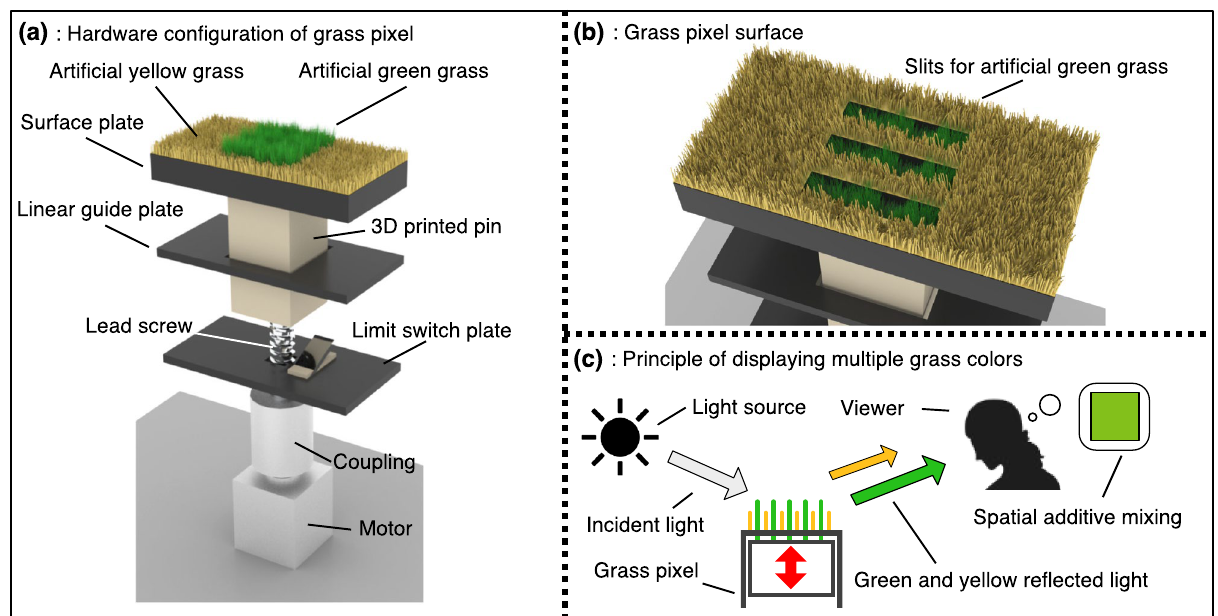
Figure 3. Design of grass pixel system. ( a ) A grass pixel is developed using a linear actuator system operated by a motor. Artificial green and yellow grass is planted on a top surface of a 3D printed pin and a surface plate, respectively. ( b ) The surface plate has slits to move the artificial green grass in and out of the artificial yellow grass. ( c ) The grass pixel displays multiple grass colors based on an area ratio of the artificial green and yellow grass through spatial additive mixing. This figure was created using Autodesk 3ds Max version 2021 (https:// www. autod esk. com/ produ cts/ 3ds- max/ featu res) and Serif Affinity Designer version 1.10.0 (https:// affin ity. serif. com/ en-